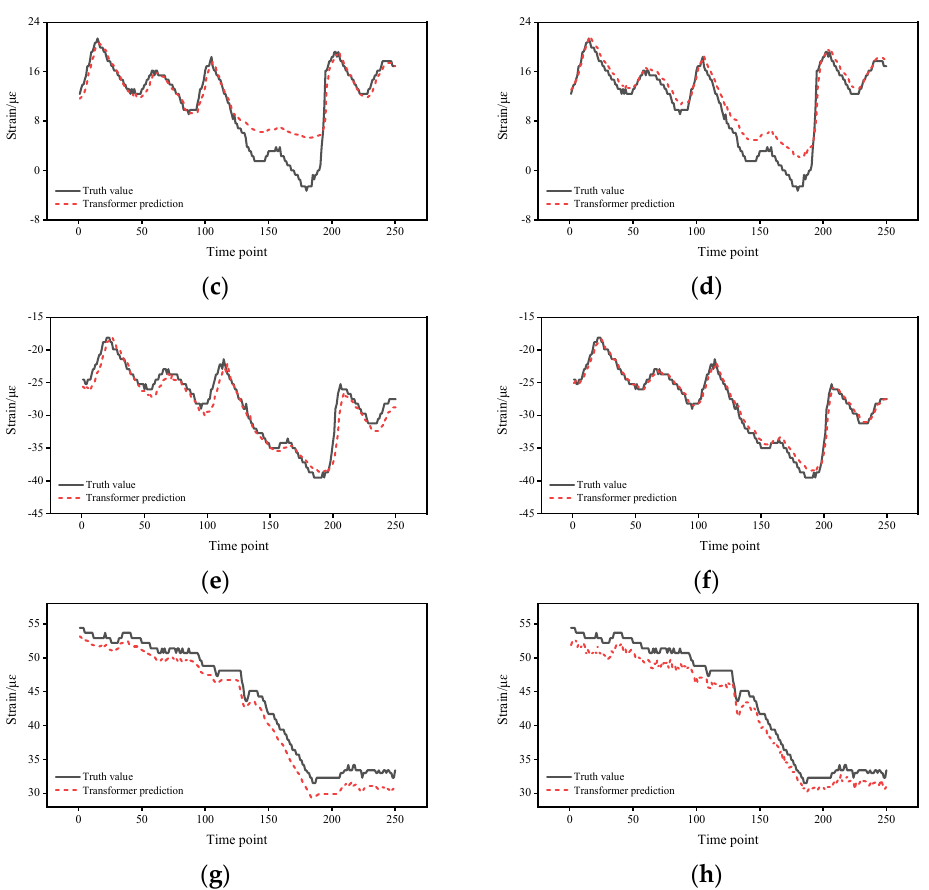
Figure 10. The prediction results of Transformer and LSTM when the input points are 3 points: ( a ) Transformer prediction for S01. ( b ) LSTM prediction for S01. ( c ) Transformer prediction for S02. ( d ) LSTM prediction for S02. ( e ) Transformer prediction for S03. ( f ) LSTM prediction for S03. ( g ) Transformer prediction for S09. ( h ) LSTM prediction for S09.